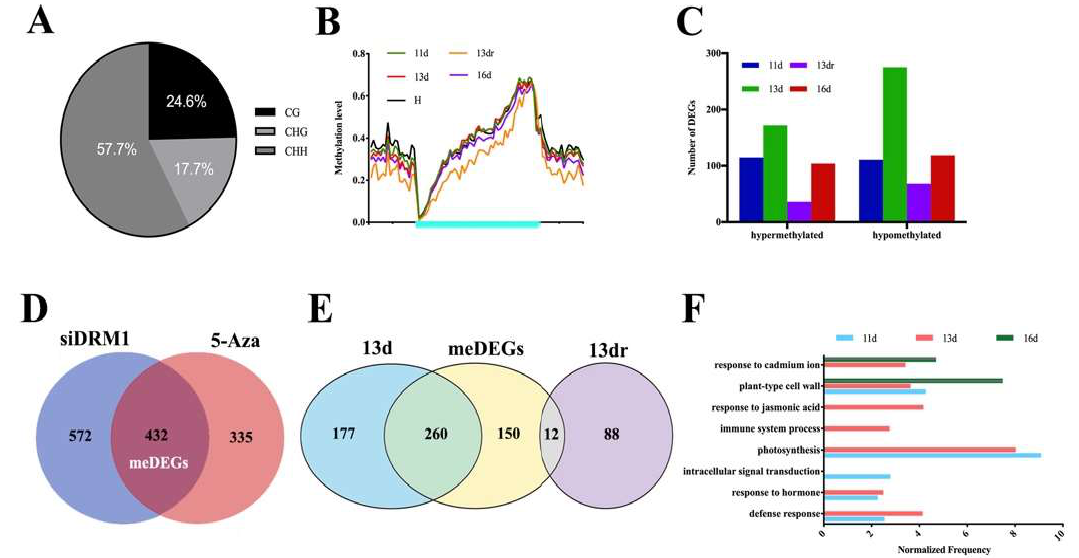
Figure 2. Methylation contexts in the gene body correlate with gene expression. ( A ) Context enrichment of DMR-covered genes; ( B ) Methylation level of gene body (cyan region) and flanking regions (black region); 11d, 13d, 13dr and 16d means infected plants at 11dpi, 13dpi, 13dpi (recovered sites) and 16dpi. H means healthy plants. ( C ) Number of genes affected by hyper- and hypo-DMRs mapping to the gene body that were differentially expressed (up-regulated and down-regulated); ( D )